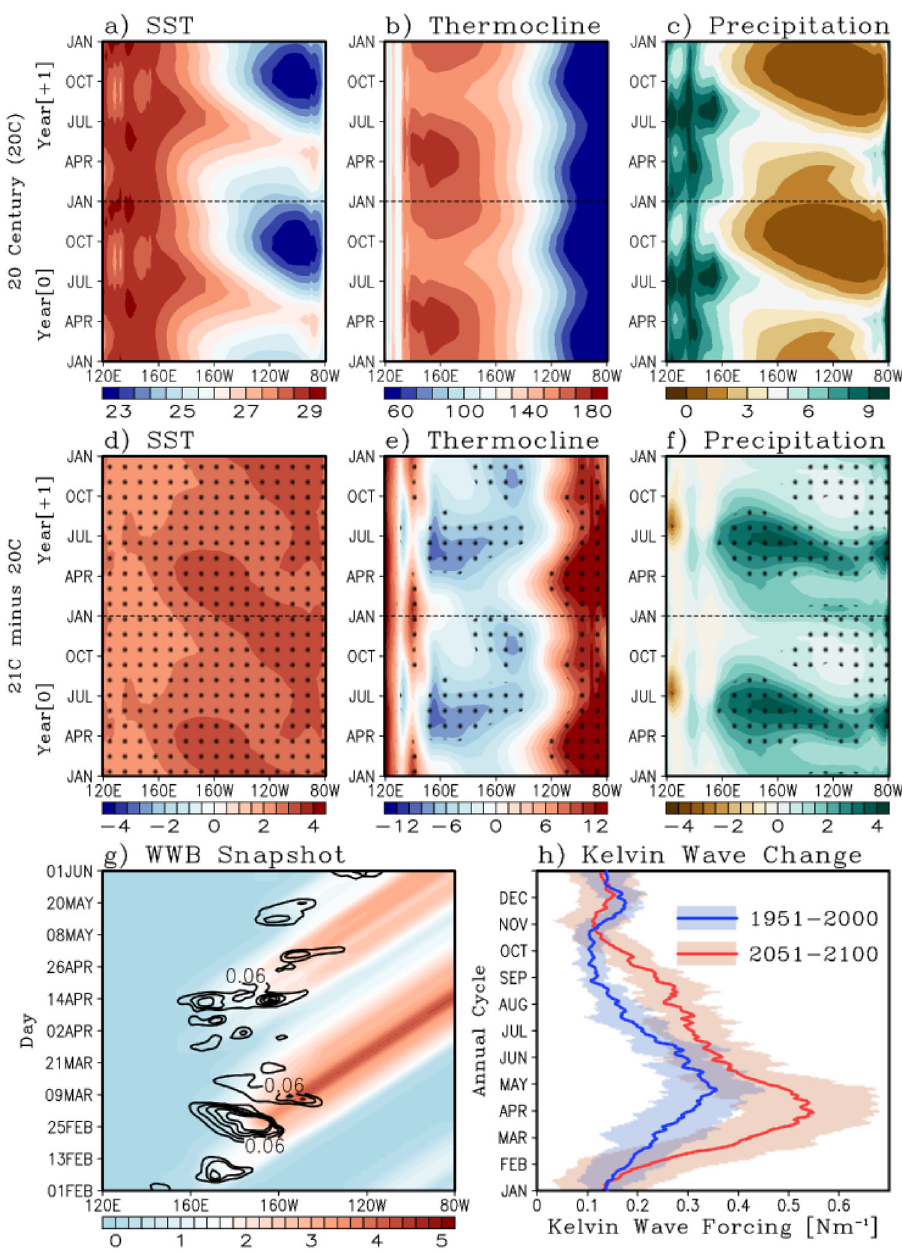
Fig. 3 Equatorial Paci fi c climatology and projected changes, as simulated by CESM-LENS. Two-year repeated monthly climatology of a sea surface temperature [°C], b thermocline depth [m], and c precipitation [mm/day], averaged 5°S-5°N during 1951 – 2000. Panels d – f show the projected change in climatology, 2051 – 2100 minus 1951 – 2000. The monthly climatology is computed as a time mean (for each calendar month) of the ensemble mean of all 30 ensemble members. Hatching indicates where the differences are statistically signi fi cant at the 95 th percentile, based on a bootstrapping technique (see Methods). g A typical example illustrating the relationship between WWBs [contours, N m − 2 ] and the resulting downwelling equatorial Kelvin wave forcing [color shading, N m − 1 ] as estimated using Eq. 2. h Daily climatology of the downwelling equatorial Kelvin wave forcing for the 20 th (blue) and 21 st (red) Century integrated across the Paci fi c (Eq. 2). The thick lines represent the ensemble mean, while the shading corresponds to the ensemble spread (full min-max intra-ensemble